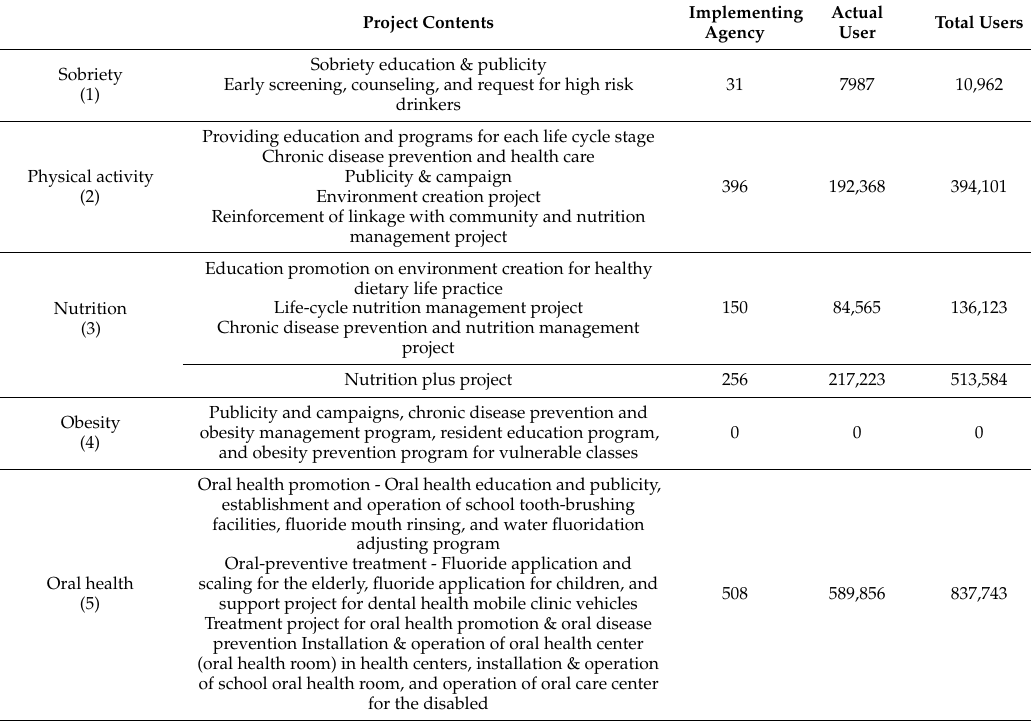
Table 2. Community integrated health